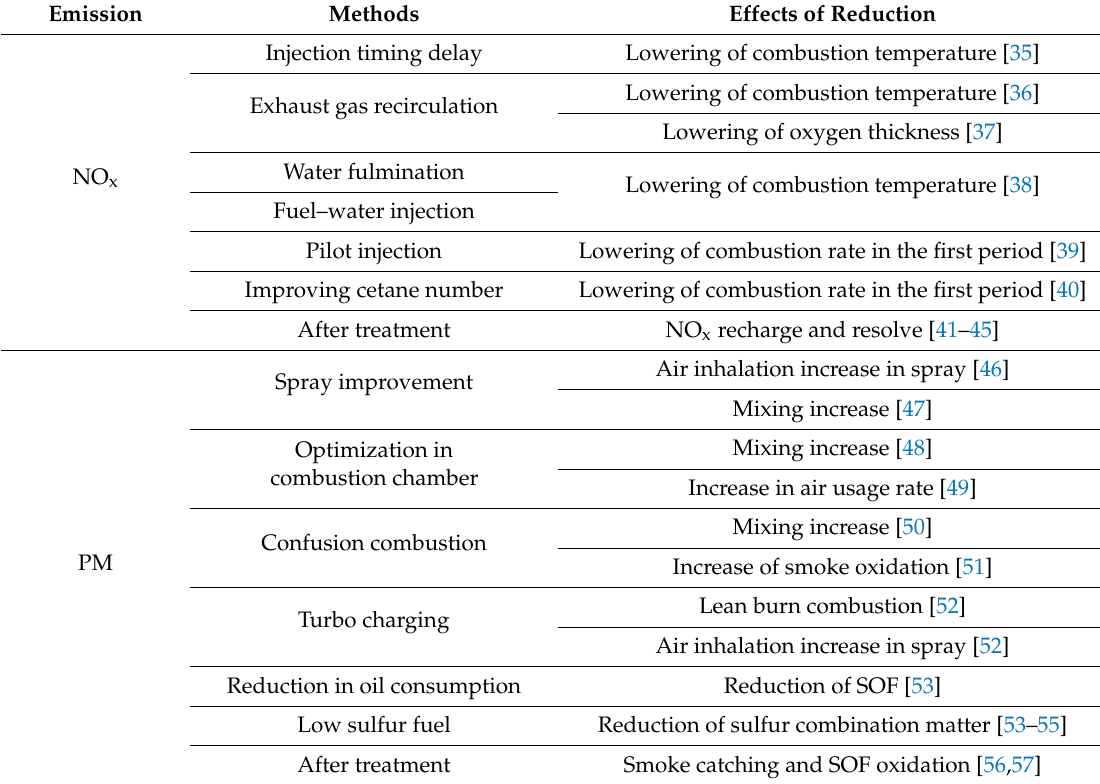
Table 2. Causes of PM and NO x generation and mitigation measures.